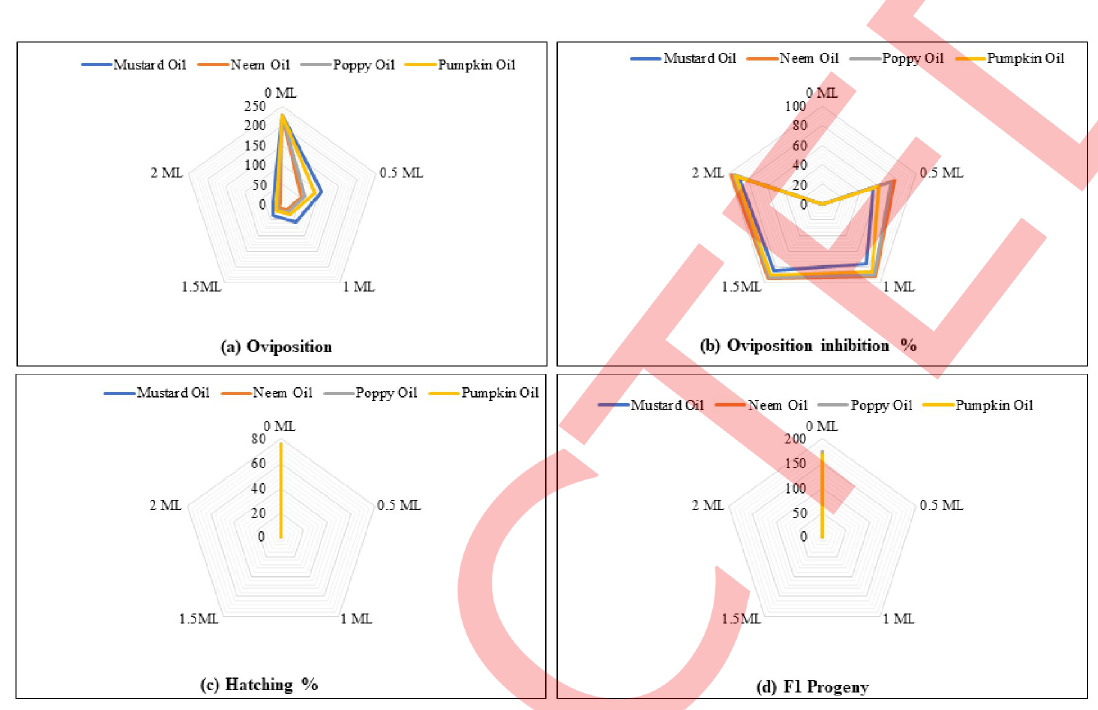
Fig 3. The impact of different botanical oils and their concentrations on oviposition (a), oviposition inhibition % (b), hatching (c), and F1 progeny (d) of C . maculatus . https://doi.org/10.1371/journal.pone.0267987.g003 Highly significant difference was noticed in botanical oils and their concentrations for ovi- position inhibition (Table 2). Different treatments, i.e., neem (2.0 ml), pumpkin (0.5 ml), mus- tard (0.5 ml), and control (0.0 ml) significantly differed from each other, while remaining treatments were non-significant (Fig 3b). Hatching and emergence of F1 progeny was not observed in all botanical oils-treated grains (Fig 3c and 3d). However, F1 progeny (171%) was recorded in the control treatment (Table 2). Due to non-emergence of adults from the botanical oils-treated grains, all botanical oils exhibited their potency towards C . maculatus (adults). Hundred percent first progeny reduc- tion was recorded in all botanical oils (Fig 4, Table 2). Table 2. The impact of different botanical oils and their concentrations on oviposition, oviposition inhibition, hatching, F1 progeny and F1 progeny reduction of C . maculatus